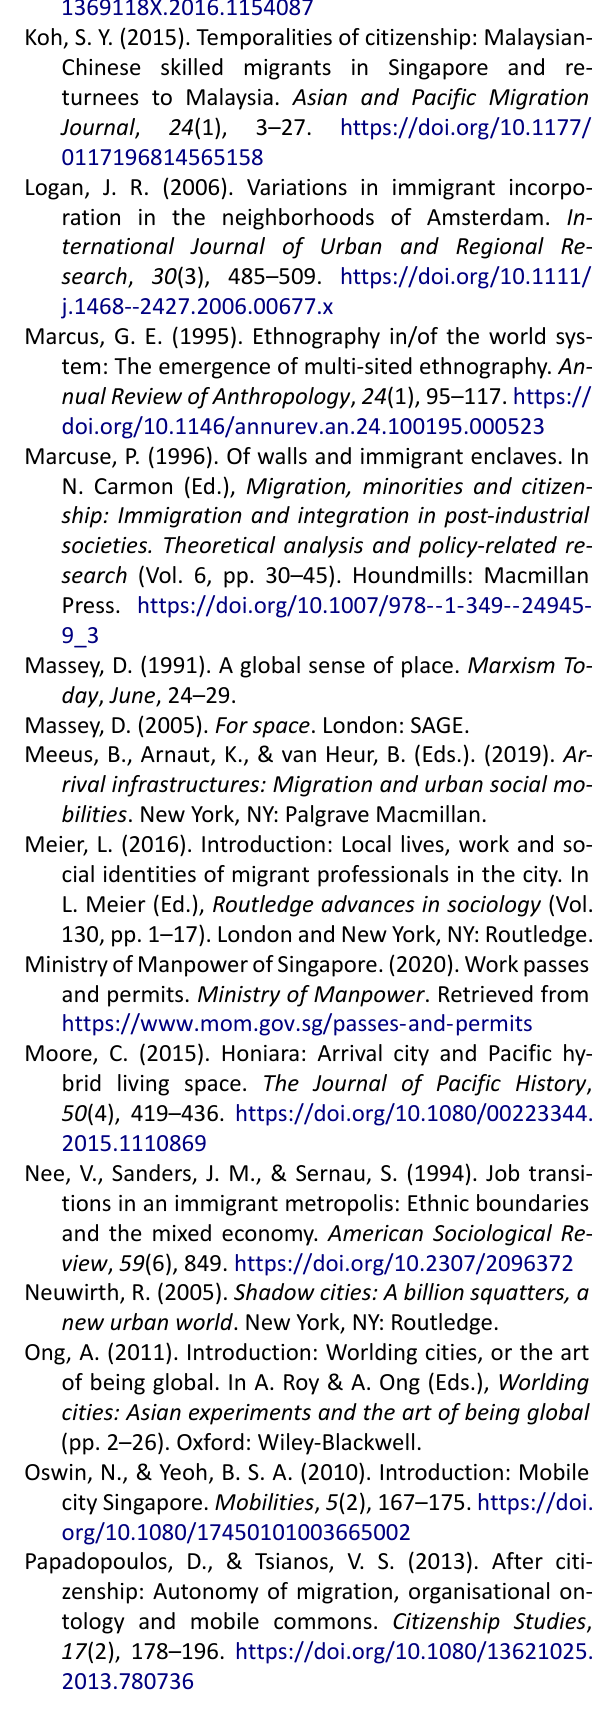
table: Labour force. Department of Statistics Sin- gapore . Retrieved from